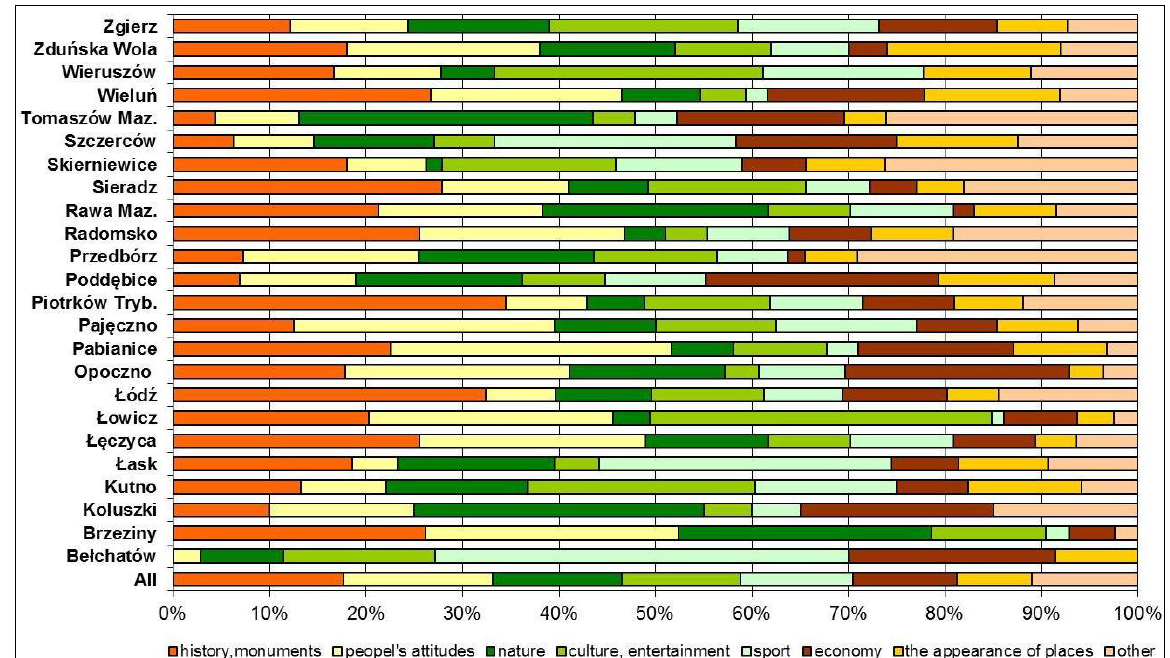
Fig. 4. Reasons to take pride in the place of residence (by the number of